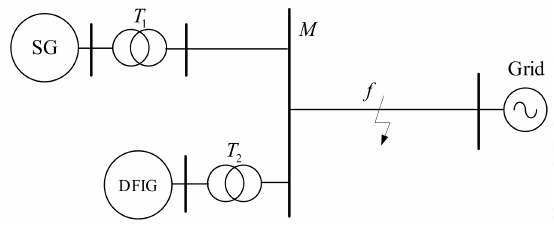
Figure 6. Simulation system consist of a DFIG and a SG.